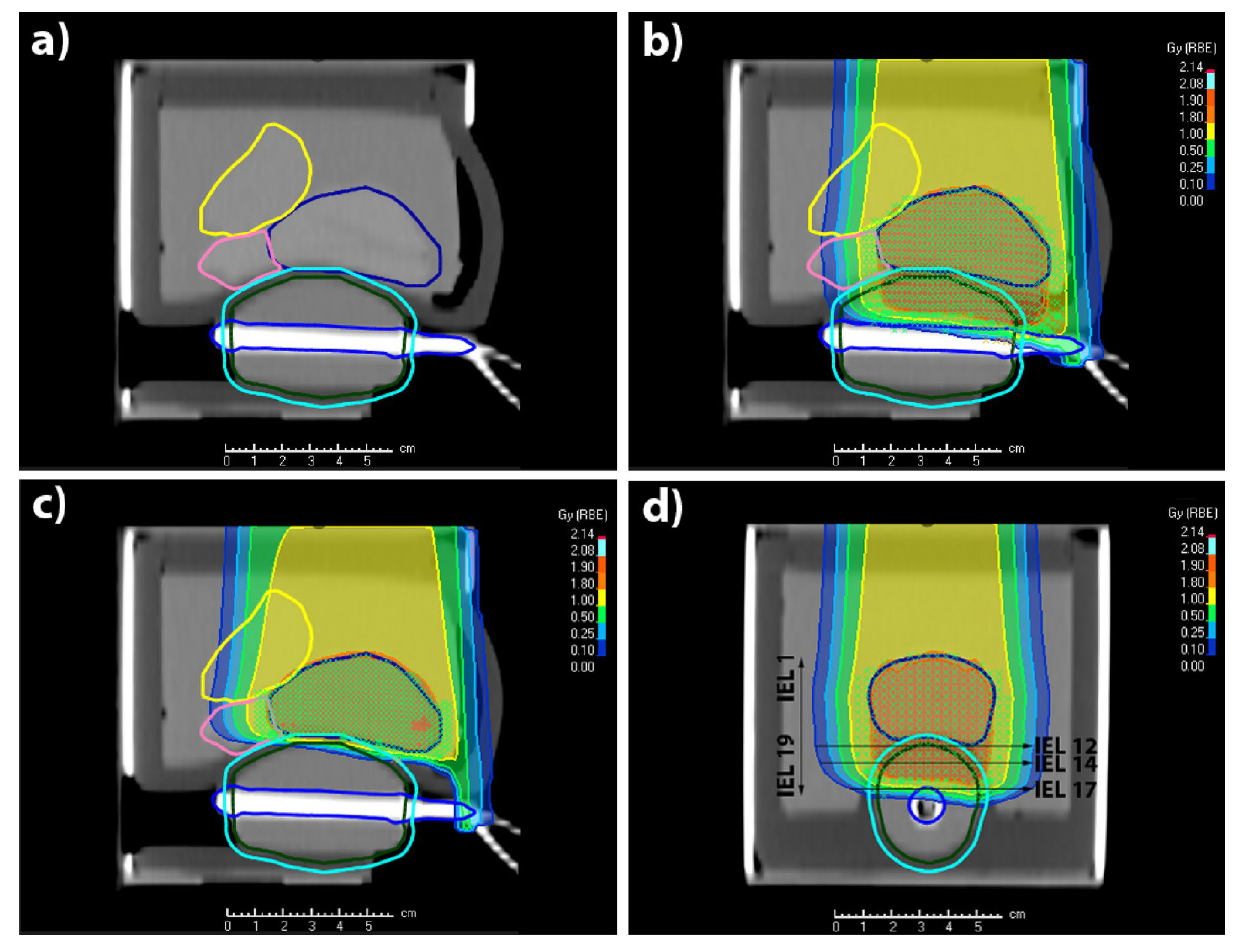
Figure 4. Phantom computed tomography and anterior proton plans. ( a ) Sagittal view of a computed tomography of the prostate phantom with the ERB. The spacing between the prostate and the ERB is visible as well as the seminal vesicles and the bladder. ( b–c ) Sagittal view of two anterior plans either overlapping with the ERB or conforming to the prostate. ( d ) Coronal view of the overlapping plan where all 19 IELs are present. All spots in the distal IELs overlap with the ERB, while the proximal IELs (12–14) just overlap with its central